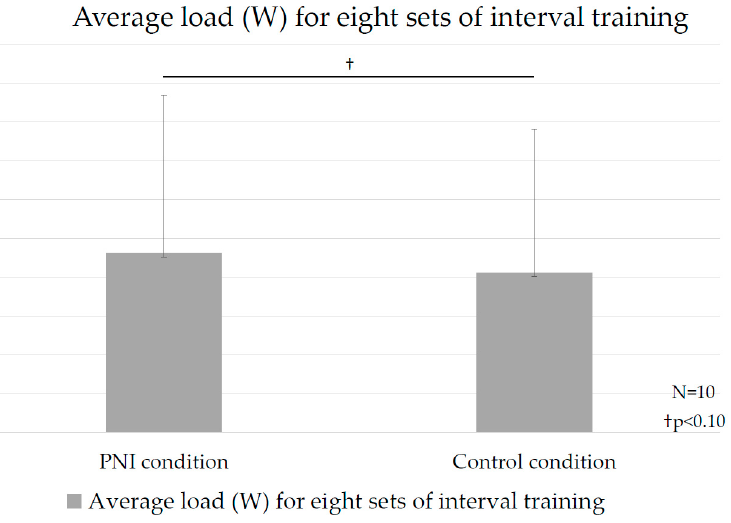
Figure 6. Comparing the average load (W) for 8 sets of interval training in PNI and control conditions.